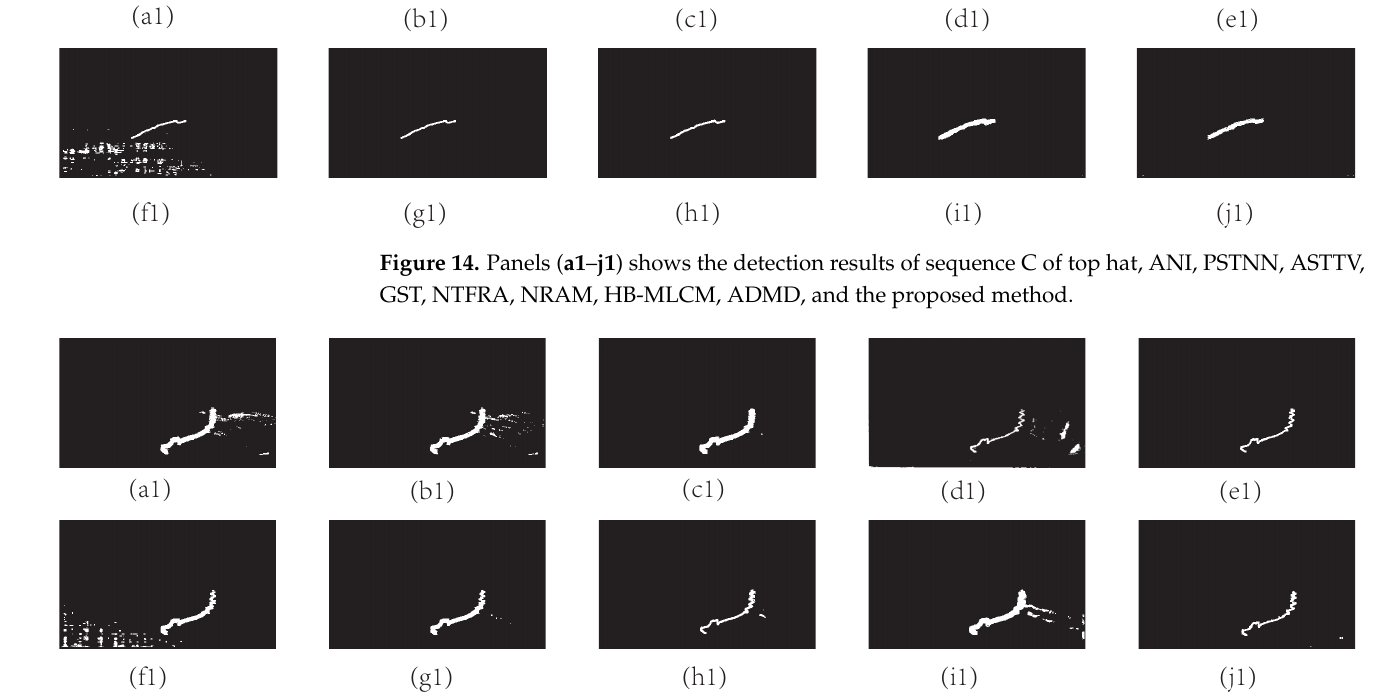
Figure 15. Panels ( a1 – j1 ) shows the detection results of sequence D of top hat, ANI, PSTNN, ASTTV, GST, NTFRA, NRAM, HB-MLCM, ADMD, and the proposed